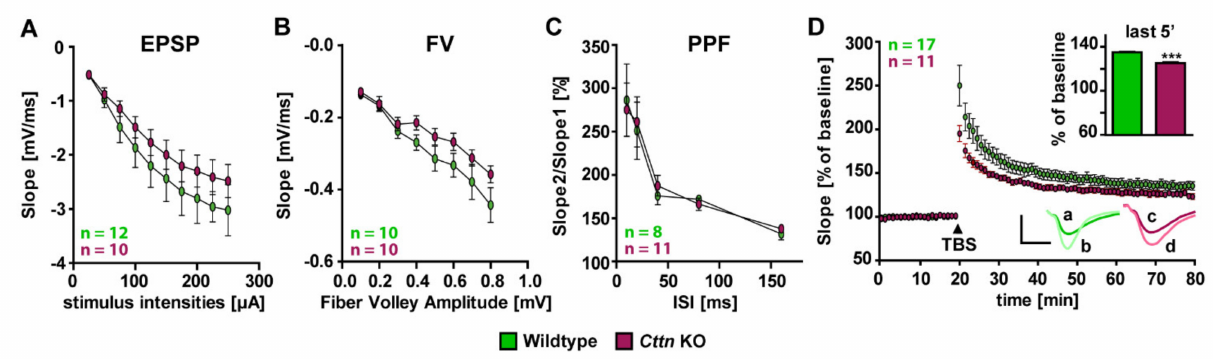
Figure 2. Electrophysiological characterization of Cttn -knockout mice. ( A , B ) Characterization of basal synaptic transmis- sion via measurements of excitatory postsynaptic potentials (EPSP) as well as input-output measurements (‘Fiber Volley’, FV) in acute hippocampal slices from WT and Cttn-deficient animals. ( C ) Analysis of short-term plasticity in WT and Cttn -KO acute hippocampal slices as evaluated by paired-pulse facilitation (PPF). ( D ) Long-term potentiation induced via theta-burst stimulation (TBS) after 20 min of baseline recording at the Schaffer collateral to CA1 pathway in acute hippocampal slices derived from WT and Cttn -KO mice. Representative single fEPSP responses are shown for (a) WT Ctrl (b) WT LTP (c) Cttn KO Ctrl (d) Cttn KO LTP. Scale Y = 1 mV, X = 5 ms. Data information: n = number of slices; Statistic tests used: For normal distribution of data: Kolmogorov-Smirnov Test, Parametric Tests: Two-Way ANOVA and Sidak’s Multiple Comparisons, Non-Parametric Tests: Kruskal-Wallis Test and Dunn’s test or Student’s T-Test; data depicted as means ± SEM, detailed information on p values as well as statistical tests is depicted in Table S1; significances are indicated by *** p value <